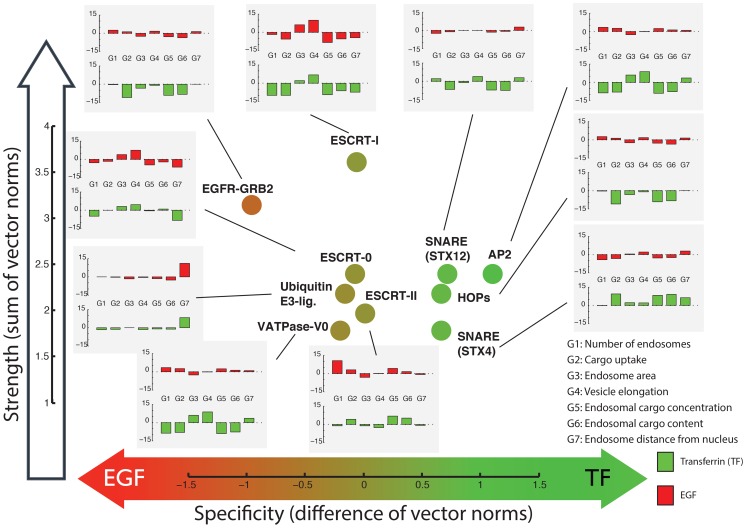
Selected protein complexes with enriched phenotypes.Each complex is represented by its reference profile, which is computed as the most consistent signature across all members of the complex. The analysis is based on 19 parameters for each channel (EGF and transferrin, TF) and two co-localization parameters (TF with EGF and EGF with TF). The x-axis shows the difference between the Euclidean (or L2) norm of the transferrin and the EGF parameters  the y-axis represents the strength of the phenotype computed as the sum of the norm of both the transferrin and the EGF signals . Each protein complex is shown as a circle, its color reflecting the primary direction of the phenotype (value on x-axis). Inset bar-plots show summary versions of the reference phenotypic profiles by projecting them from 40 to 14 dimensions (red: response on EGF channel, green: response on transferrin channel). See Table S1 for details on the parameters. More details about complex membership are shown in Supplementary Figure S13.